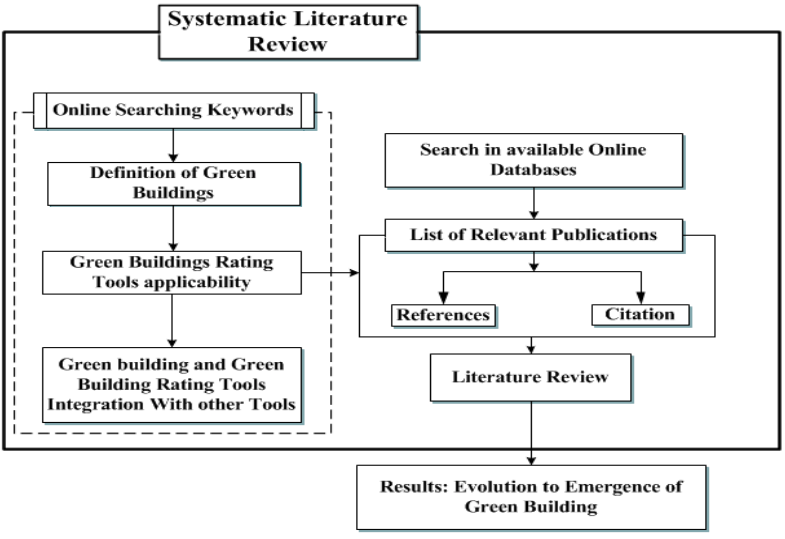
Figure 2. Flow Chart of Systematic Literature Review.